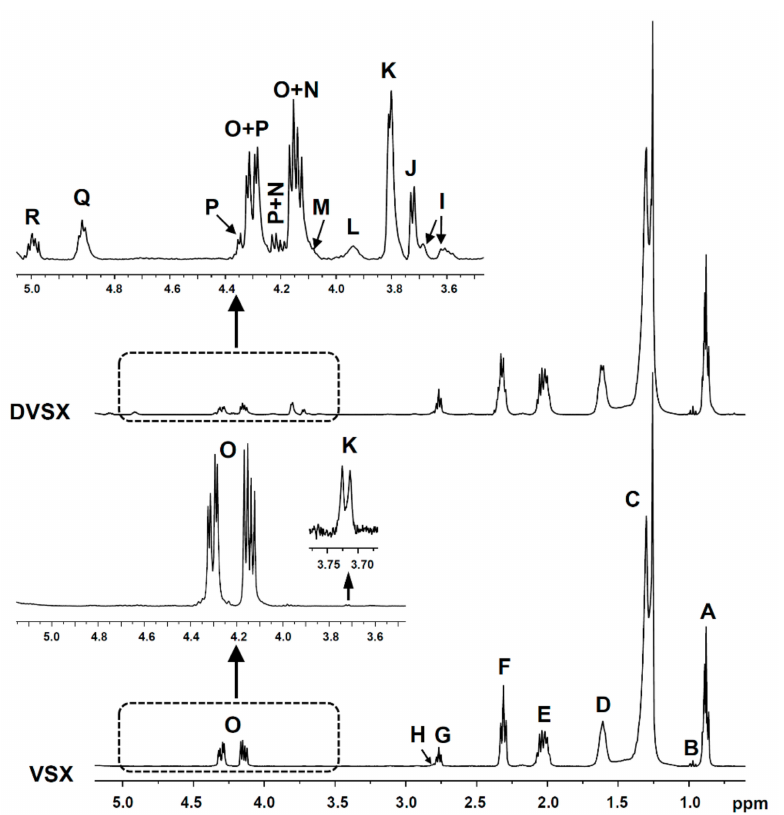
Figure 1. Region between 0.5 and 5.1 ppm of the 1 H NMR spectra of VSX and DVSX samples, and enlargements of the region between 3.5 and 5.1 ppm, where the main proton signals of glycerides appear. The signal letters agree with those of Tables S2 and S3 of the Supplementary